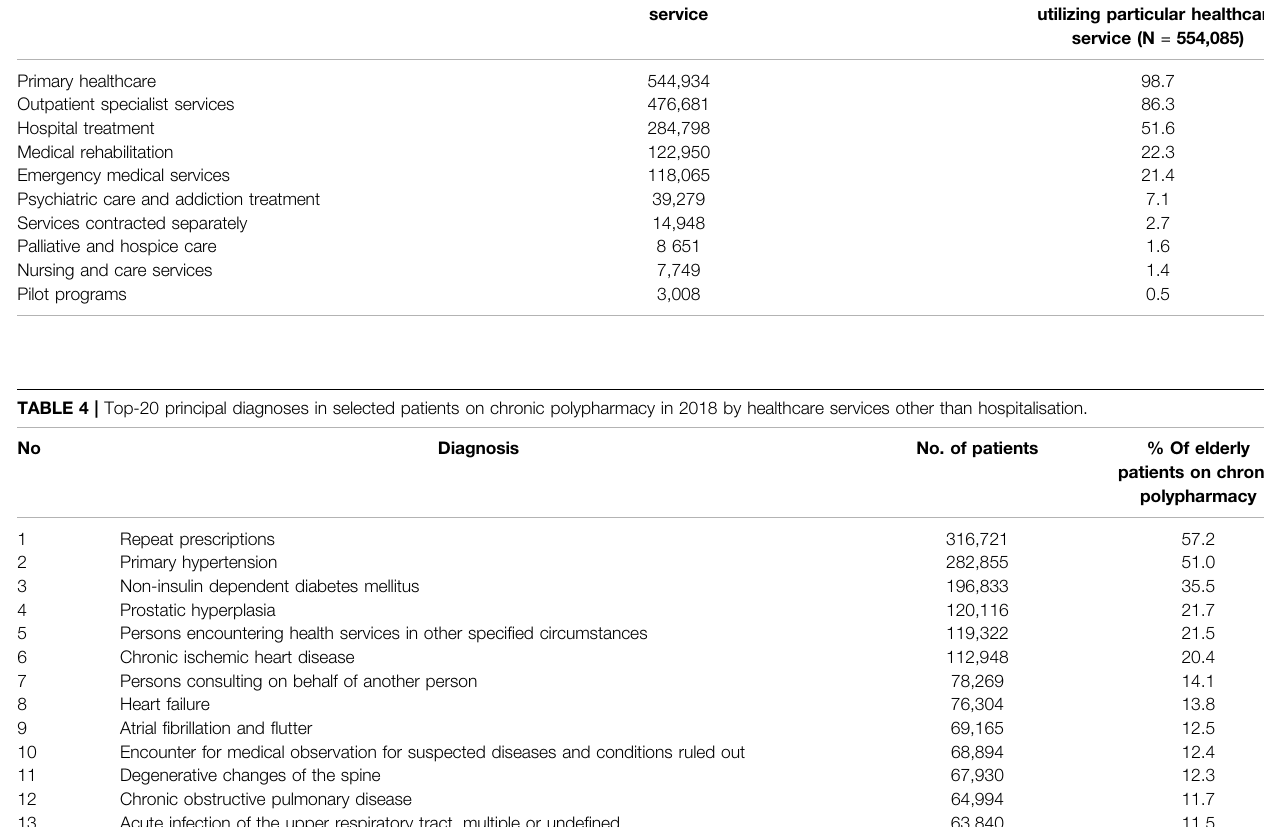
TABLE 3 | Healthcare services utilization by elderly patients on chronic polypharmacy. Health service